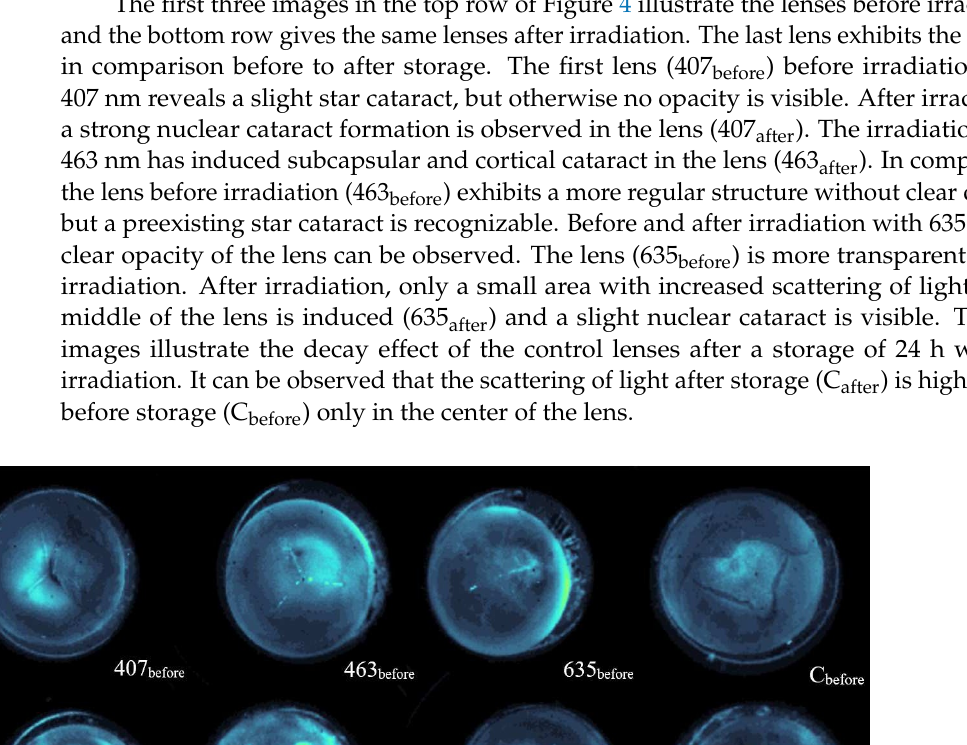
Figure 3. An outer and inner ring can be observed in the dark field image. The outer ring shows the edge of the mounting disk, in which the lens is stored in the medium and the inner ring represents the edge of the lens.